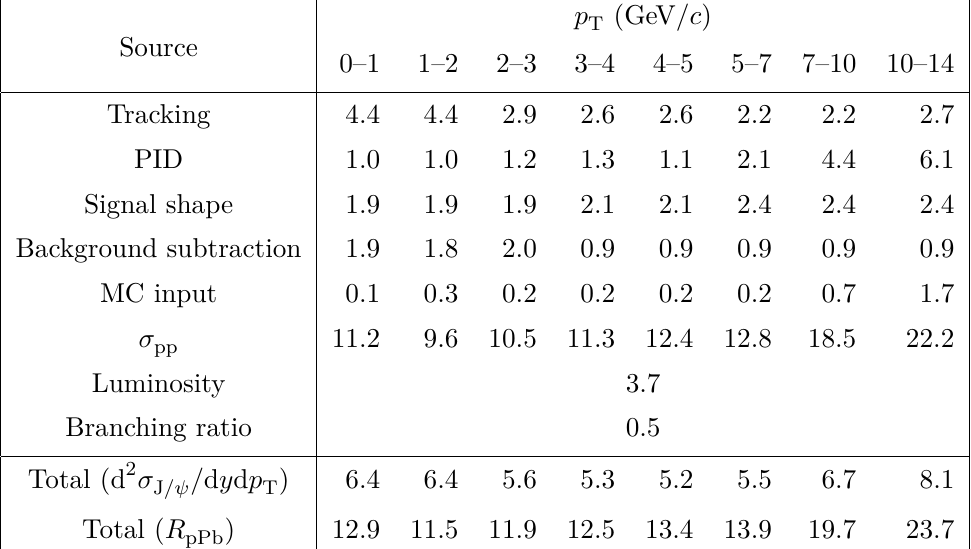
in different p intervals. All contributions pPb T